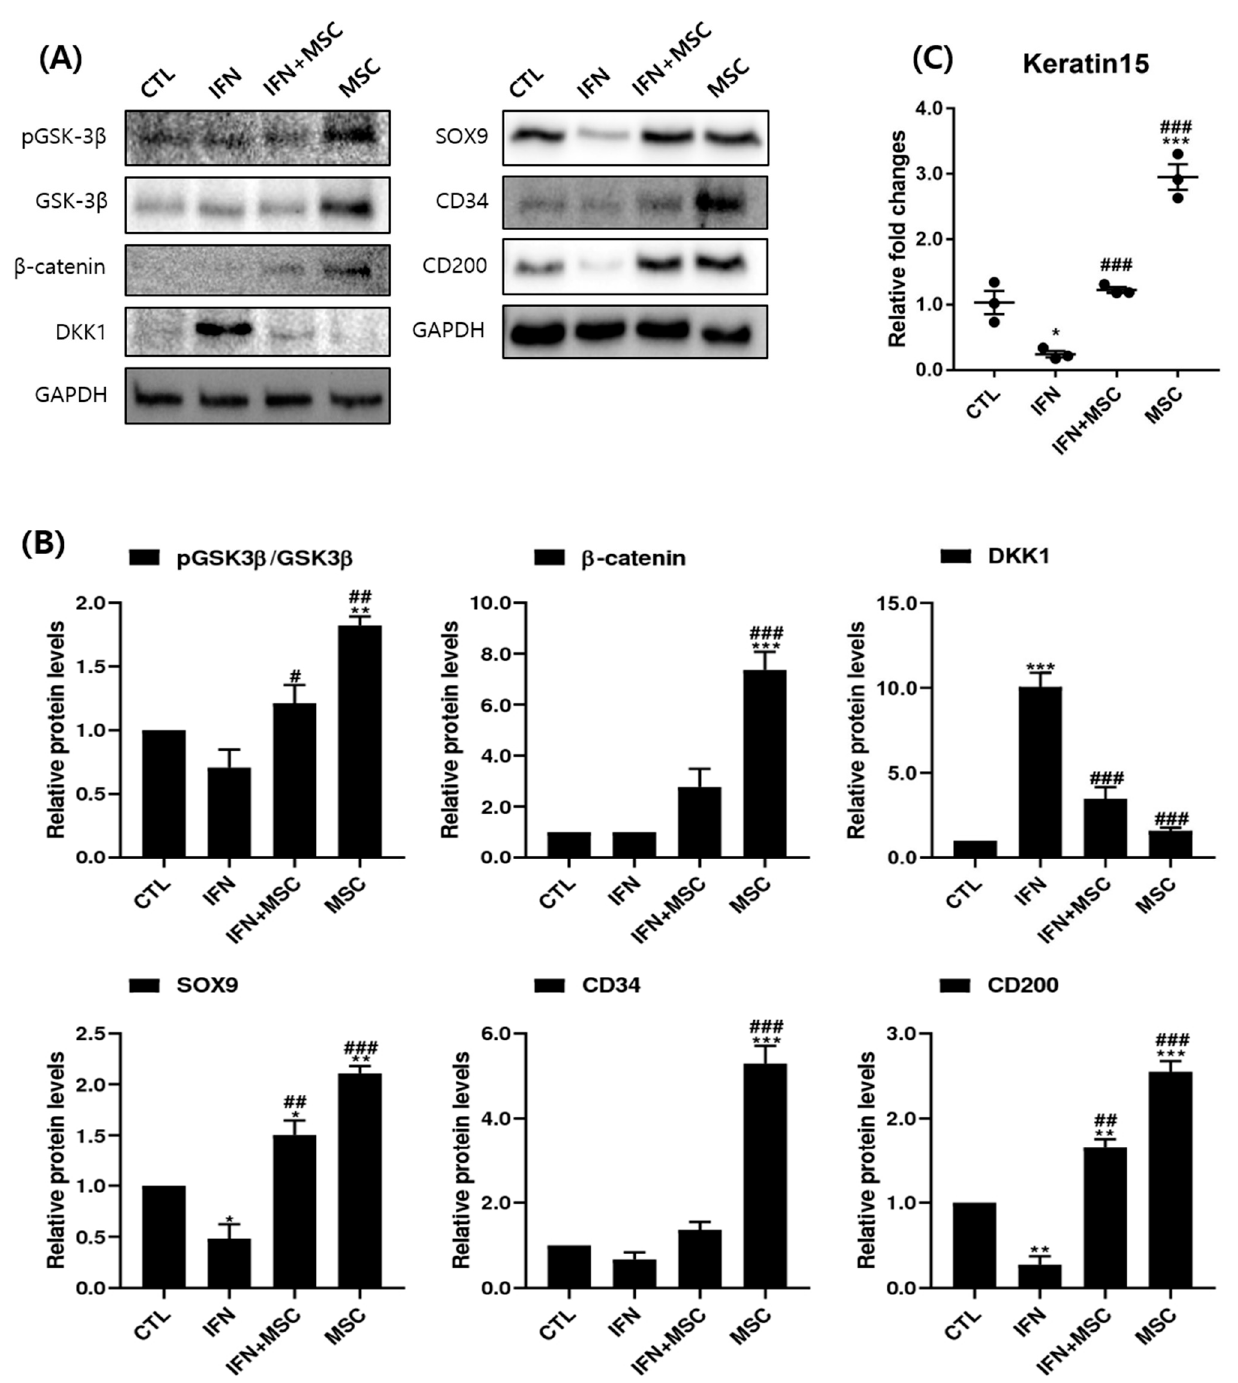
Figure 5. Analysis of protein levels of WNT/ β -catenin pathway-related markers and hair stem cell markers induced by IFN- γ and MSCT. ( A ) Western blotting band images and ( B ) graphs of the quantitation of the Western blotting bands. Expression levels of the markers were assessed by Western blotting and GAPDH was used as a loading control. ( C ) Analysis of Keratin 15 expression by RT-PCR. hHMSC treatment increased the protein expression of β -catenin, phosphorylated GSK-3 β , SOX9, CD34, and CD200 compared to the controls and reverted the effect of IFN- γ in hORSCs. The levels of DKK1 were increased in the IFN- γ -treated group and reverted by MSCT. The levels of Keratin 15 were downregulated by IFN- γ and reverted by MSCT. Error bars represent the mean ± SEM, n = 3. Statistically significant at * p < 0.05, ** p < 0.01, and *** p < 0.001 compared to the control and # p < 0.05, ## p < 0.01 and ### p < 0.001 compared to the IFN- γ -treated group.